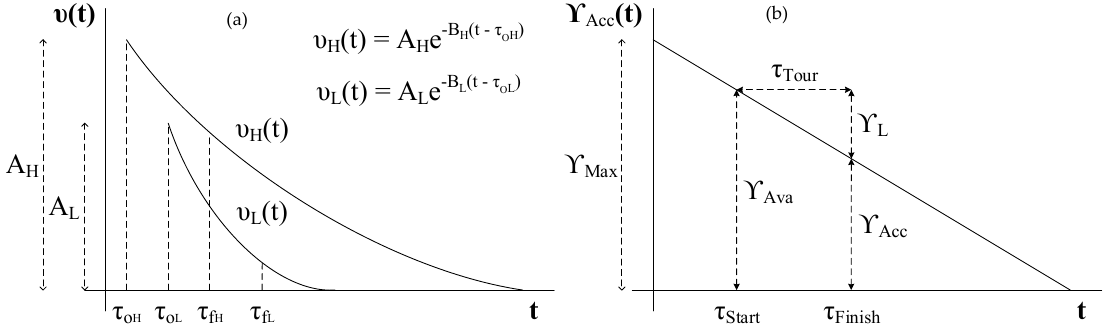
Figure 2. Infotentials: ( a ) The figure on the left is an example of exponentially decaying infotentials that we use for modelling and analyzing high-priority and low-priority events; ( b ) The figure on the right shows various parameters and measures that we use for comparative analysis of path planning